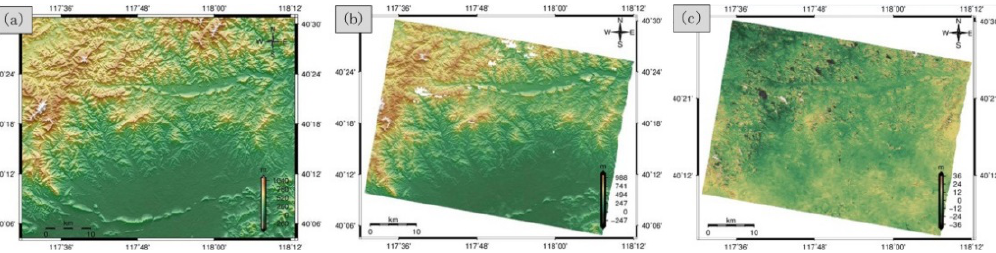
Figure 6. DEM products of Tangshan region. (a) is the SRTM DEM map; (b) is the DEM generated by this paper; (c) is the elevation difference map of SRTM DEM and DEM generated by this paper.